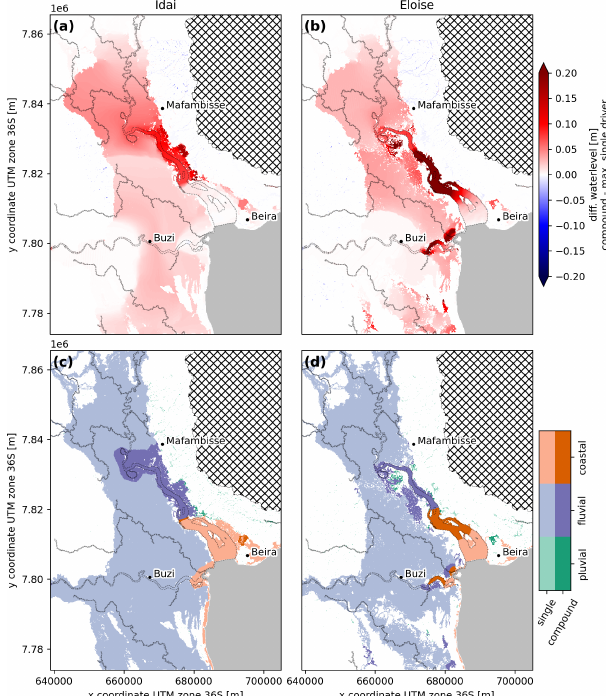
Figure 7. Compound flood dynamics during Tropical Cyclone Idai (a, c) and Tropical Cyclone Eloise (b, d) illustrated by the difference between water levels from the compound flood scenario and the maximum of all single-driver scenarios (a, b) and the main flood driver based on the single-driver scenario with the maximum water level (c, d) . The main driver is indicated with light colors where the water level results from a single flood driver and dark colors where it results from more than one flood driver, also referred to as the transition